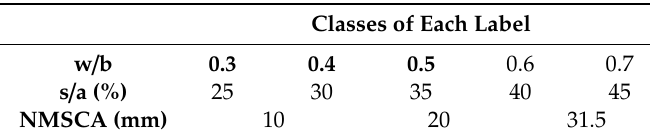
Table 1. Classes of mix proportion labels. Classes of Each Label